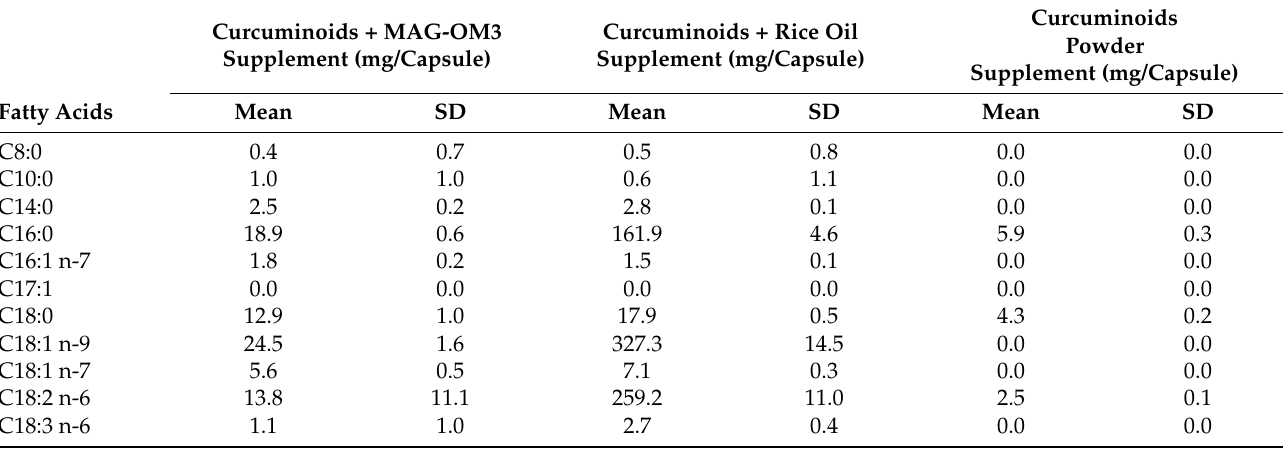
Table 2. Fatty acids profile of the supplements 1